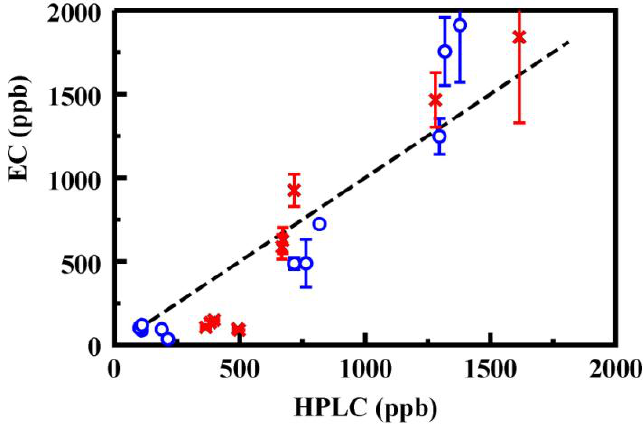
Figure 4. Preconcentration from ground water. Points here represent the results for quantification of samples using the prototype system with analysis by HPLC (x-axis) and EC (y-axis): TNT (−0.62 V ± 0.02; blue) and DNT (−0.77 ± 0.02; red). The line